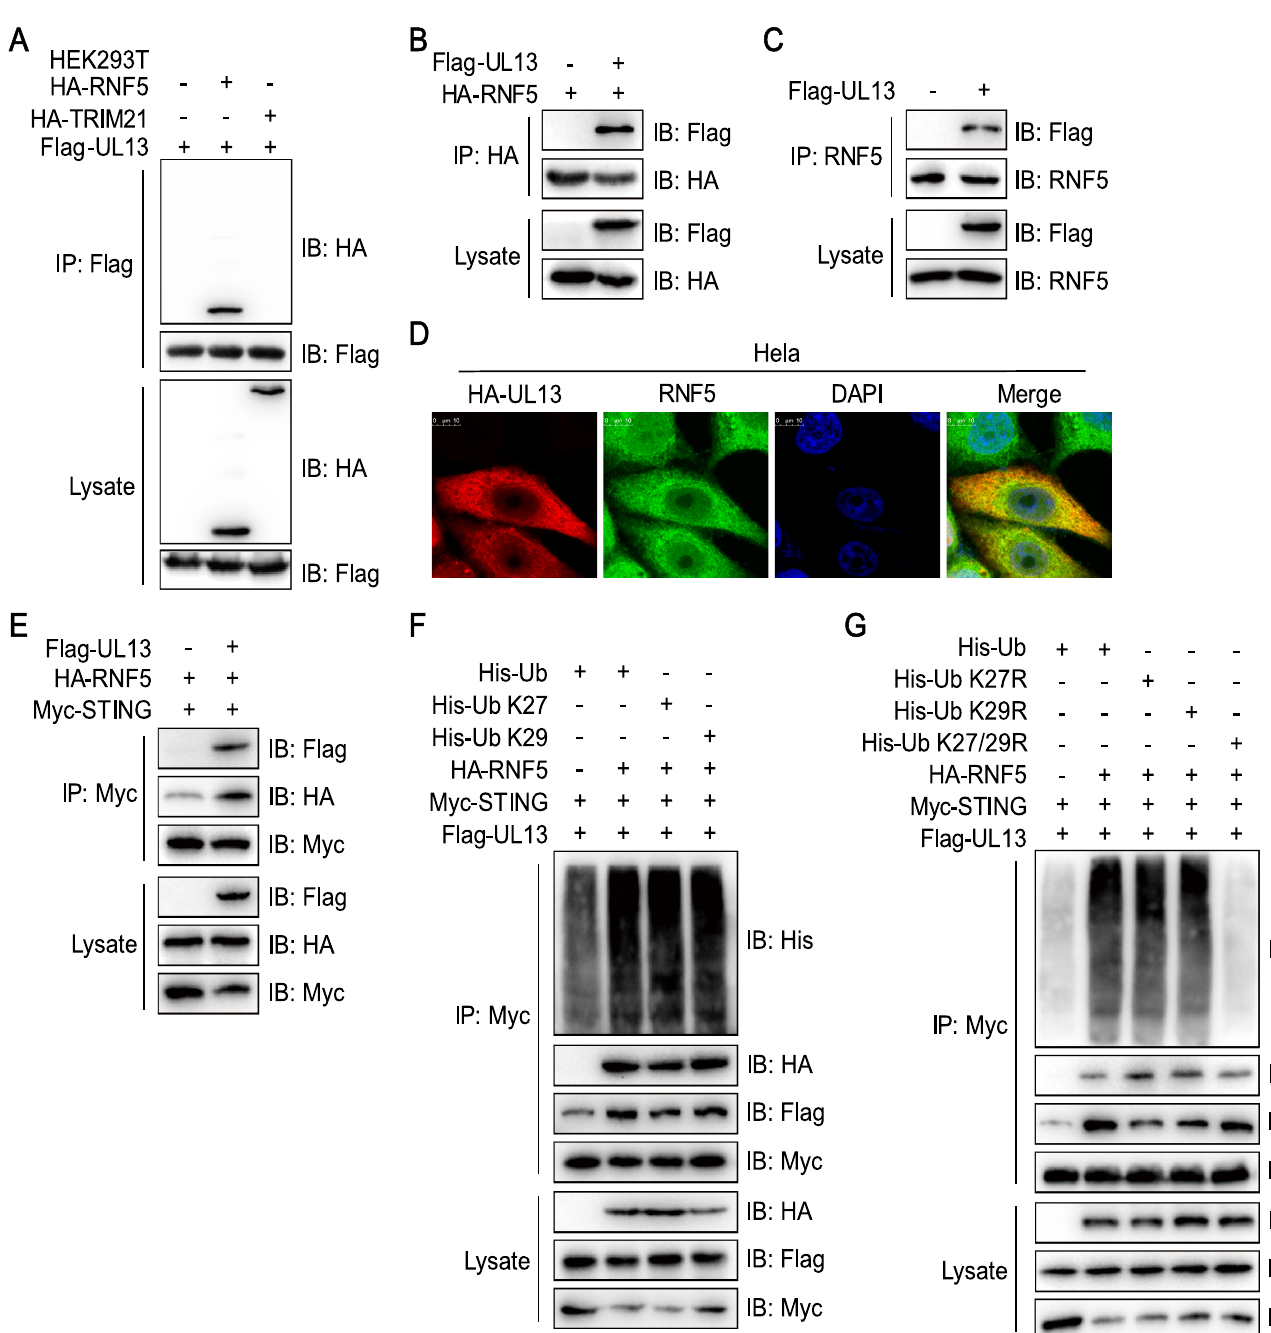
Fig 5. UL13 recruits E3 ligase RNF5 to induce STING ubiquitination degradation. (A to C) Immunoprecipitation analysis of HEK293T cells expressing Flag-UL13 together with HA-TRIM21 and HA-RNF5 (A) or HA-RNF5 (B) or Flag-UL13 alone (C). Anti-Flag (A), anti-HA (B), or anti-RNF5 (C) immunoprecipitates were analyzed by immunoblotting with anti-HA (A) and anti-Flag (B, C) antibodies. Levels of the transfected proteins were analyzed by immunoblotting with anti-Flag and anti-HA antibodies (A, B) or anti-RNF5 antibodies. (D) Colocalization of UL13 and RNF5 in Hela cells. Cells were transfected with HA-UL13 for 24 h before confocal microscopy. Endogenous RNF5 was labeled by anti-RNF5 antibody. (E) Immunoprecipitation analysis of HEK293T cells expressing Myc-STING and HA-RNF5 with or without Flag-UL13. Anti-Myc immunoprecipitates were analyzed by immunoblotting with anti-HA and anti-Flag antibodies. The levels of the transfected proteins were analyzed by immunoblotting with anti-Flag, anti-HA, or anti-Myc antibodies. (F, G) Immunoprecipitation analysis of HEK293T cells expressing Flag-UL13, Myc- STING, and His-Ub (WT, K27, or K29 only) with or without HA-RNF5 (F) or HEK293T cells expressing Flag-UL13 and Myc-STING together with His-Ub (WT, K27R, K29R, or K27/29R only mutants) as indicated with or without HA-RNF5 (G). Anti-Myc immunoprecipitates were analyzed by immunoblotting with anti-His, anti-Flag, and anti-HA antibodies (F, G). The levels of the transfected proteins were analyzed by immunoblotting with anti-Flag, anti-HA, or anti-Myc antibodies. Scale bars, 10 μ m (D). Data are representative of two independent experiments (A-G).